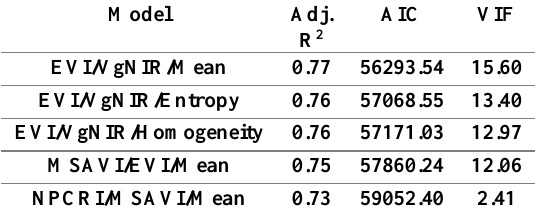
Table 5. Top five OLS models based on Adjusted R 2 and AIC which used combinations of spectral and textural indices as